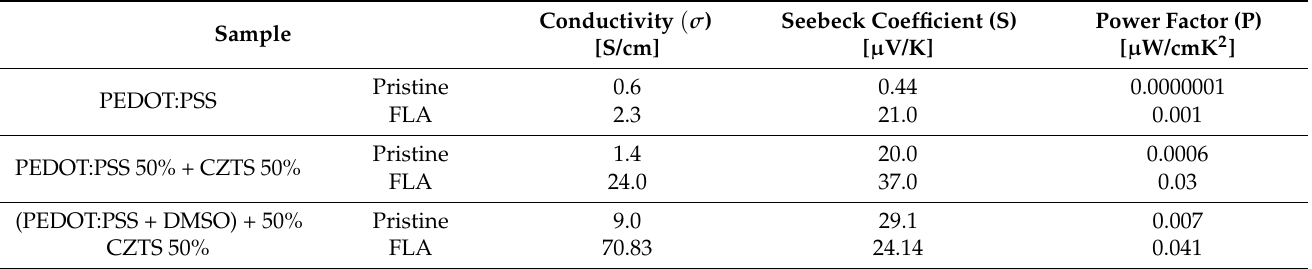
Table 1. Results of TE measurements (performed at a temperature of 310 K, when neither polymer nor NC films have deteriorated). The samples were deposited by spin-coating on glass substrates and an FLA power density was chosen to be 3 J/cm2 to avoid the decomposition of the PEDOT:PSS in the composites. The TE properties of the films were assessed via calculation of the power factor P = σ S 2 , where σ is the electrical conductivity and S is the Seebeck